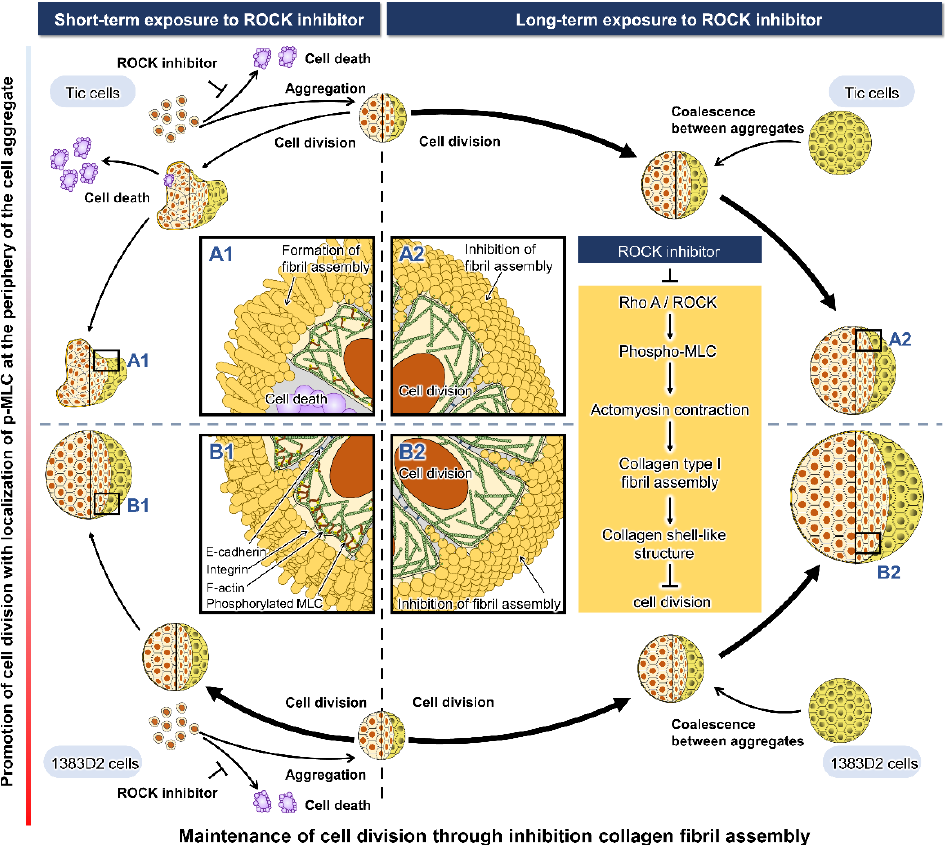
Figure 7. Schematic drawing of our hypothesis that cell-derived collagen type I regulates cell division and coalescence between aggregates of two different hiPSC lines (( A ), Tic; ( B ), 1383D2) by inhibiting actomyosin contraction in suspension culture with prolonged ROCK inhibition. Panels ( A1 – B2 ) show magnified views of the boxed areas, respectively.